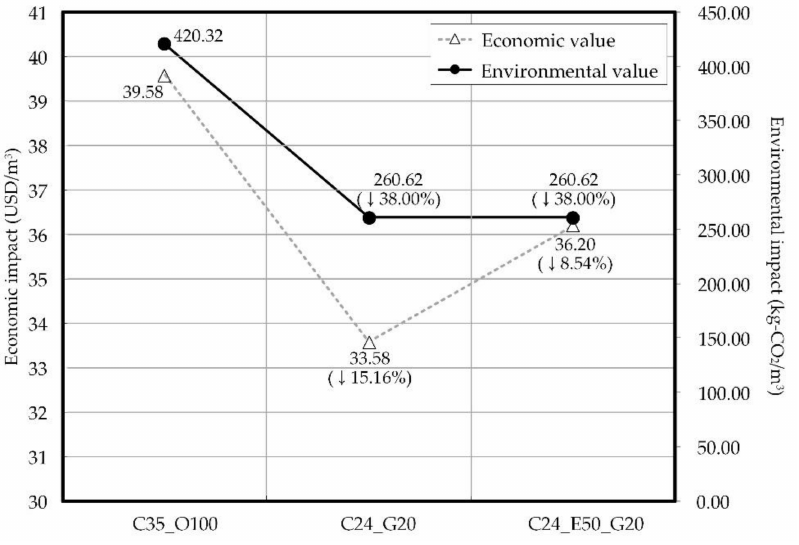
Figure 20. Results of environmental and economic impacts on